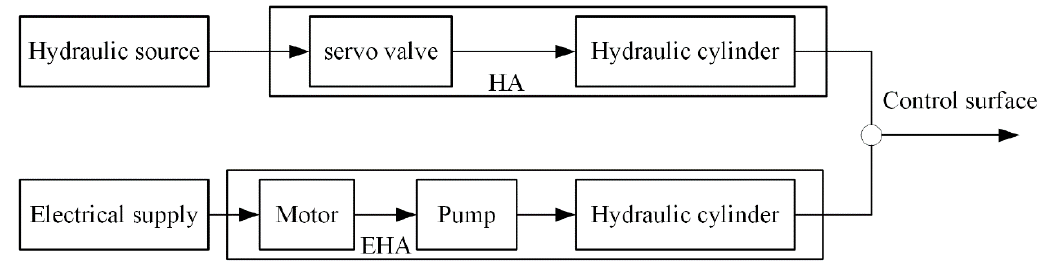
Figure 2. Logic block diagram of DRAS.